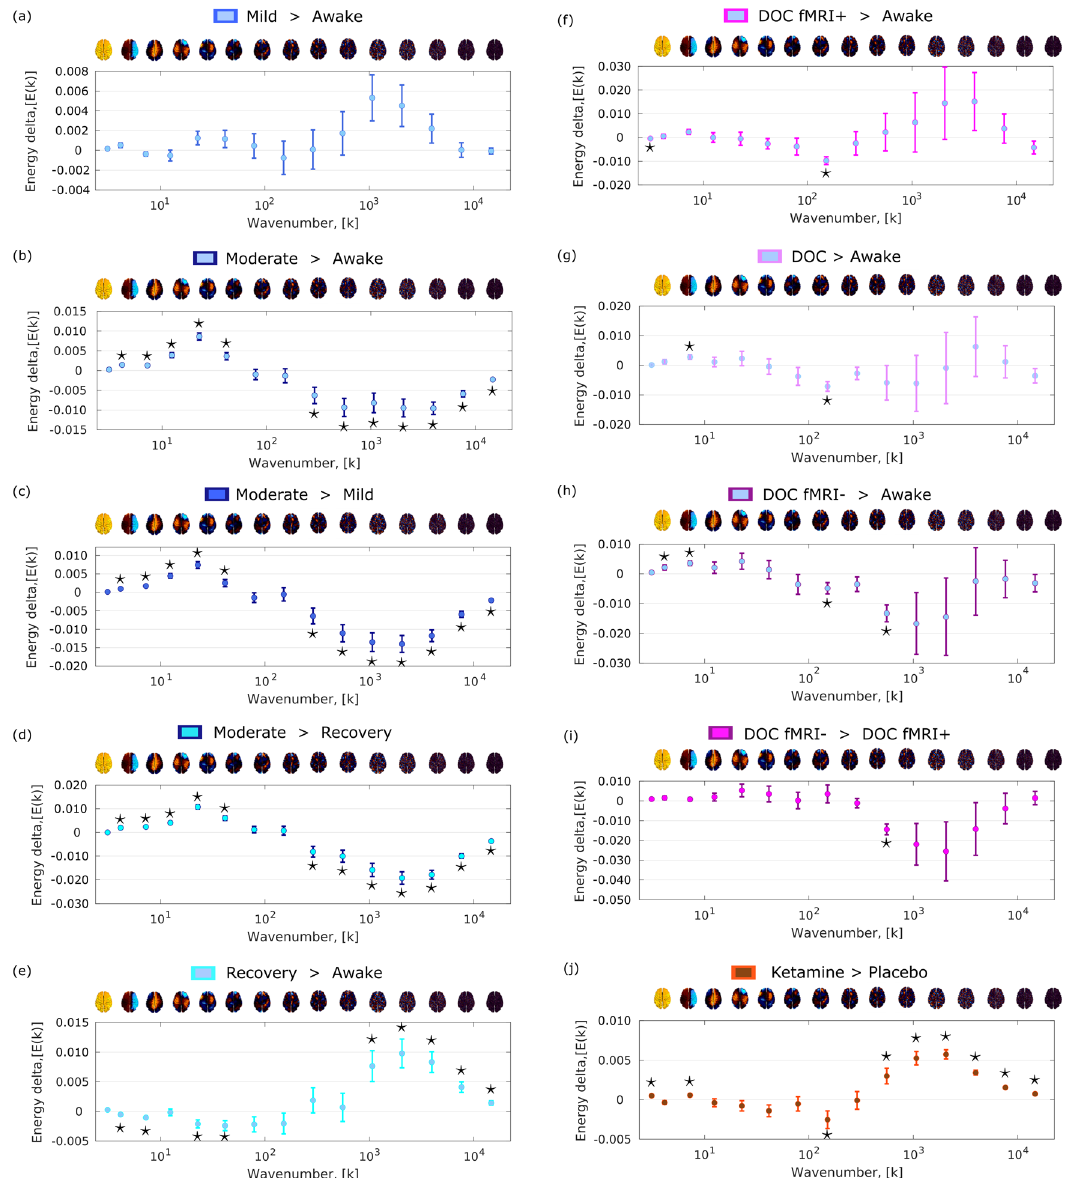
Fig. 3 Loss of consciousness and the psychedelic state are characterized by speci fi c and opposite signatures of connectome harmonic energy. Pairs of conditions (states of consciousness) were compared with linear mixed effects modelling, by treating condition as a fi xed effect and subjects as random effects. Timepoints were also included as random effects, nested within subjects. Plot shows the statistical estimates ( fi xed effect of condition) for each contrast, and error bars indicate the 95% CIs, from the LME model. Data distributions of connectome harmonic energy for each condition and bin are shown in Supplementary Fig. 2. a Mild propofol sedation ( n = 15 subjects with 145 timepoints each) > wakefulness ( n = 15 subjects with 145 timepoints each). b Moderate anaesthesia ( n = 15 subjects with 145 timepoints each) > wakefulness ( n = 15 subjects with 145 timepoints each). c Moderate anaesthesia ( n = 15 subjects with 145 timepoints each) > mild sedation ( n = 15 subjects with 145 timepoints each). d Moderate anaesthesia ( n = 15 subjects with 145 timepoints each) > post-anaesthetic recovery ( n = 15 subjects with 145 timepoints each). e Recovery ( n = 15 subjects with 145 timepoints each) > wakefulness ( n = 15 subjects with 145 timepoints each). f DOC patients ( n = 22 subjects with 295 timepoints each) > awake healthy controls ( n = 15 subjects with 145 timepoints each). g DOC fMRI + patients ( n = 8 subjects with 295 timepoints each) > awake healthy controls ( n = 15 subjects with 145 timepoints each). h DOC fMRI − patients ( n = 14 subjects with 295 timepoints each) > awake healthy controls ( n = 15 subjects with 145 timepoints each). i fMRI − DOC patients ( n = 14 subjects with 295 timepoints each)> fMRI + DOC patients ( n = 8 subjects with 295 timepoints each). j Ketamine ( n = 20 subjects with 295 timepoints each) > placebo ( n = 20 subjects with 295 timepoints each). A brain surface projection of the connectome harmonic pattern corresponding to each frequency bin, averaged over the constituent spatial frequencies, is shown above each bin. See Supplementary Fig. 3 for our re-derivation of the LSD signature using the same preprocessing and denoising procedures as for our other data to ensure consistency. Source data are provided in Supplementary Data 1. * p < 0.05, FDR-corrected across 15 frequency